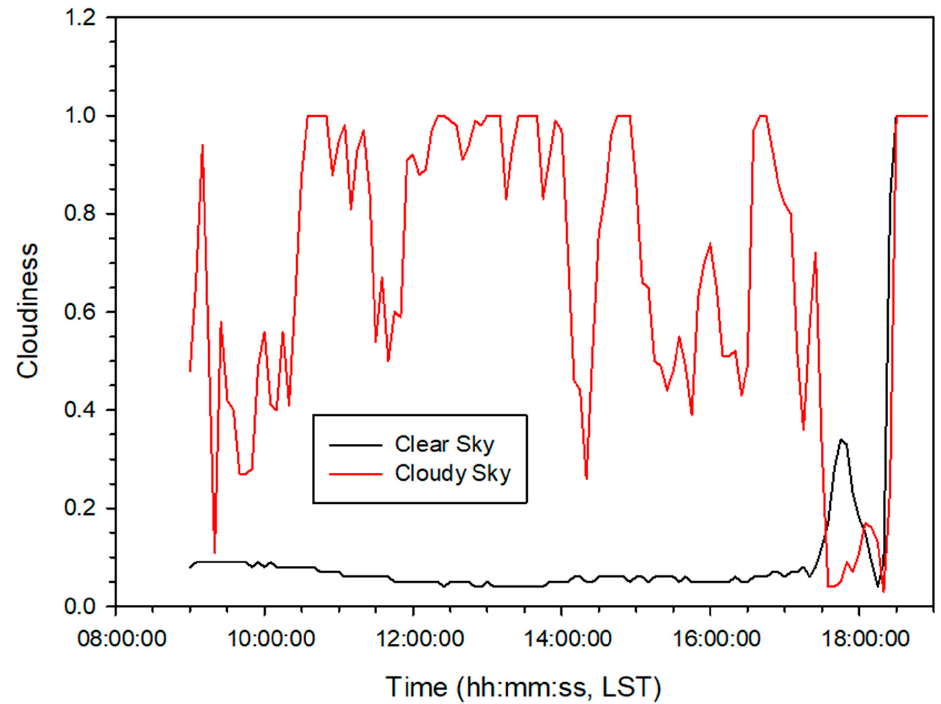
Figure 5. Time series of cloudiness obtained from the sky imager for clear (black solid) and cloudy (red solid) sky days at the Korea Institute of Energy Research (KIER) observation station. LST, Local Standard Time.